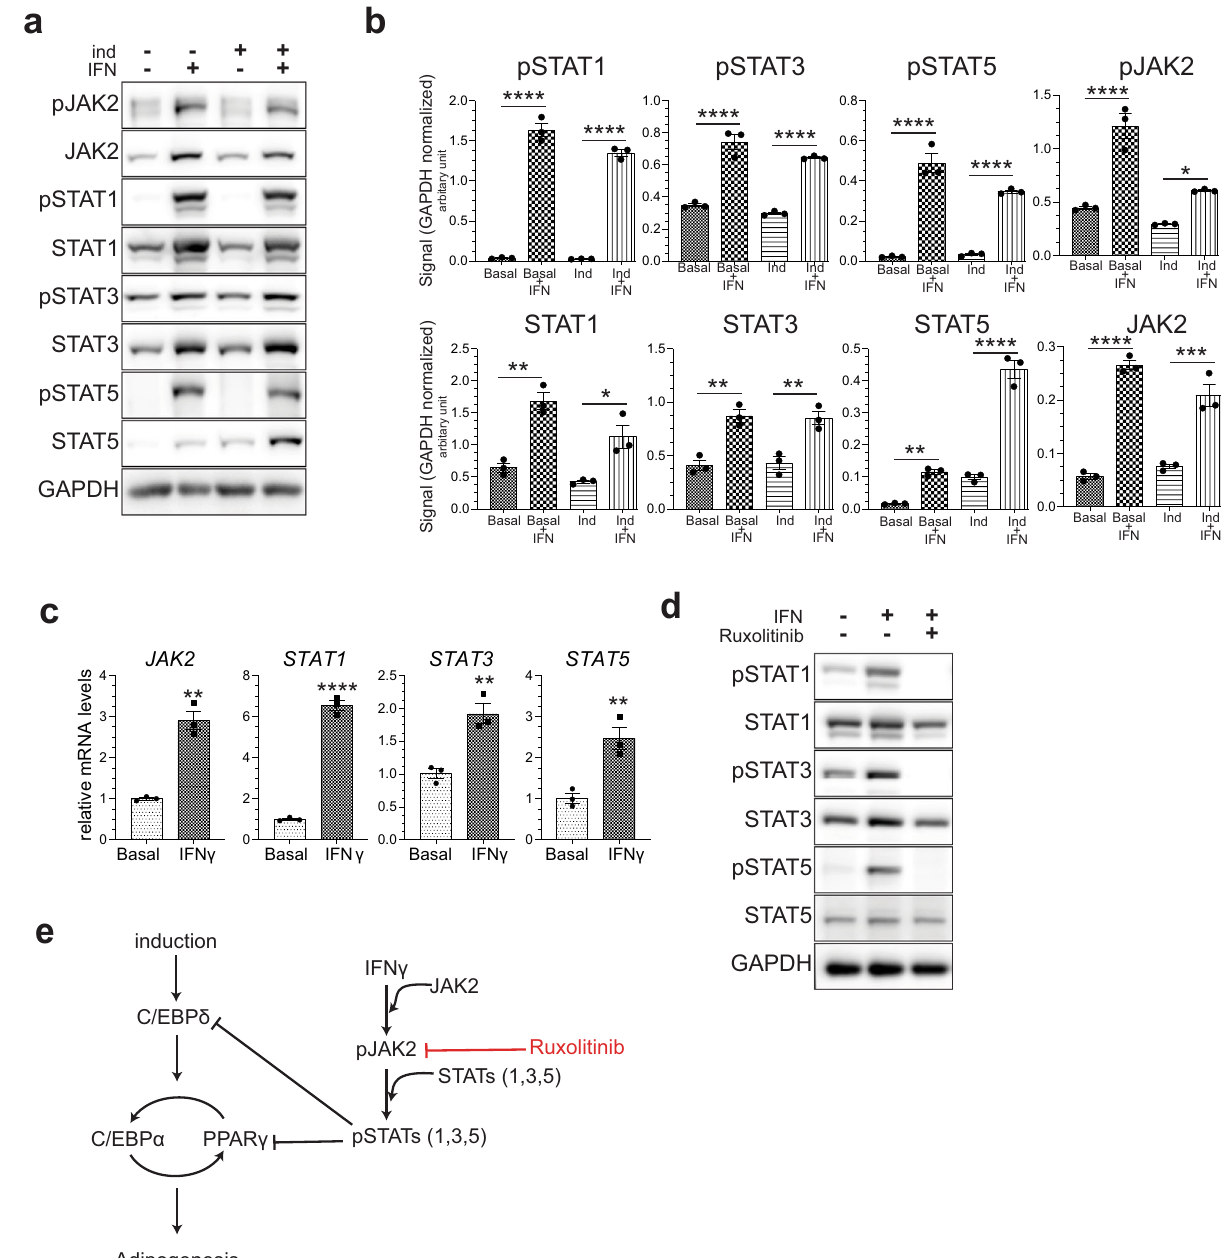
Fig. 2 Key adipogenic transcription factors are inhibited by chronic IFN γ -induced activation of selective JAK/STAT proteins. a , b Representative western blot ( a ) and blot quanti fi cation ( b , N = 3) of hVA-MSCs after 10 days of adipogenic stimulation with or without IFN γ (10 ng/ml). c qRT-PCR of cDNA prepared from hVA-MSCs cells after 10 days of treatment with/out IFN γ (10 ng/ml). Transcript levels were normalized to that of GAPDH ( N = 3). d Representative hVA-MSC western blot ( N = 2) after 12 h incubation with/out IFN γ (10 ng/ml) and/or JAK inhibitor Ruxolitinib (Ruxo) at 5 µM. e Schematic diagram representing the effects of IFN γ -activated JAK-STAT pathway on adipogenic commitment. Ind-adipogenic induction. Normal cell culture media (Ind − IFN − ) treated cells were used as the basal condition. Error bars represent mean ± SEM. * indicates statistical signi fi cance (* P < 0.05; ** P < 0.005, **** P < 0.00005) of Tukey ’ s test post one-way